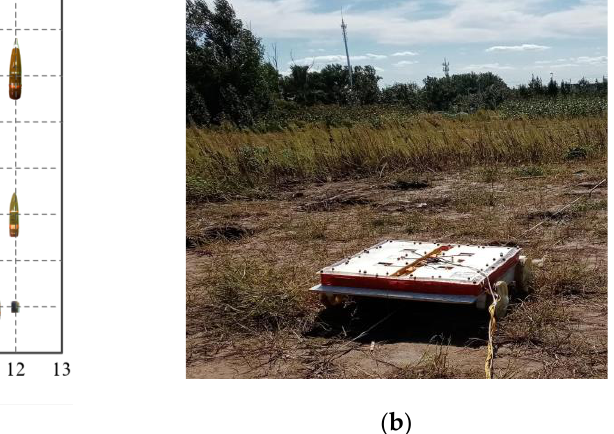
Figure 9. ( a ) Distribution of buried targets in the experiment; ( b ) picture of the field